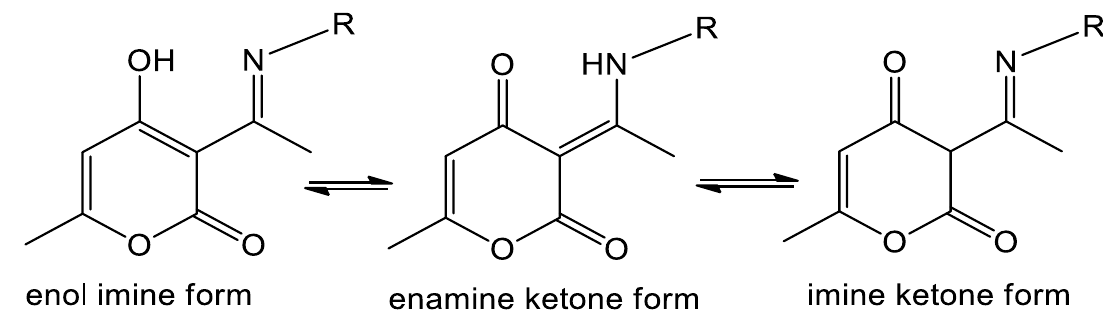
Figure 1. A schematic drawing of the aluminum compounds 1–4 showing the steric hindrance of the Al-Me groups with the imine substituents, * denoted chiral center.